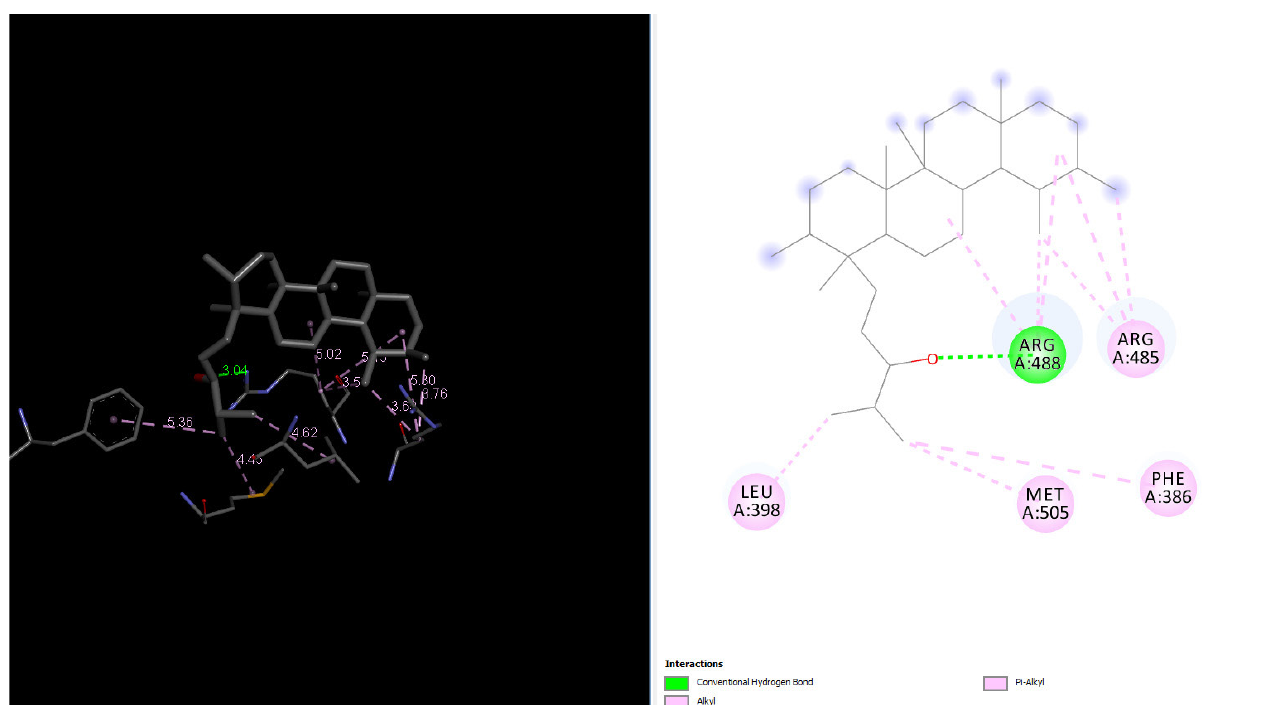
FIGURE 4 - Protein versus ligand interaction (CDC25B and α-amyrin), obtained from Discovery Studio 4.1. Hydrogen and alkyl bonding can be seen in ligand-protein